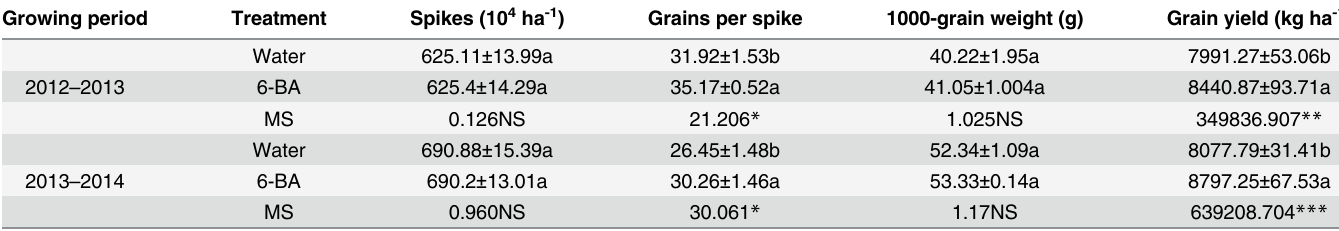
Table 1. Grain yields and main yield components of winter wheat between the two treatments for the two growing periods. Growing period